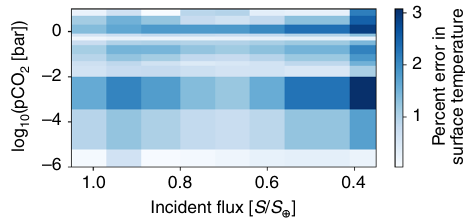
Fig. 4 The relative error between our fourth-order polynomial fi t and the full 1D radiative-convective climate model. Our polynomial fi t is valid between 1.05 S ⊕ and 0.35 S ⊕ , where S ⊕ is the solar constant. The polynomial fi t is valid for atmospheric CO 2 abundances between 10 − 6 and 10 bar. The surface temperatures predicted by the polynomial fi t reproduce the results of the 1D climate model. The maximum error in predicted surface temperature between the polynomial fi t and the 1D climate model